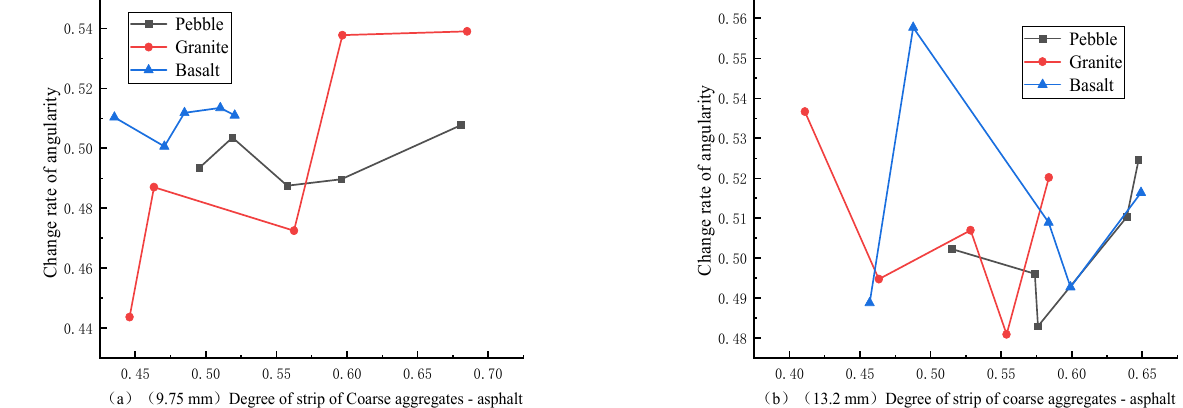
Figure 22. Relationship between degree of strip and the change rate of